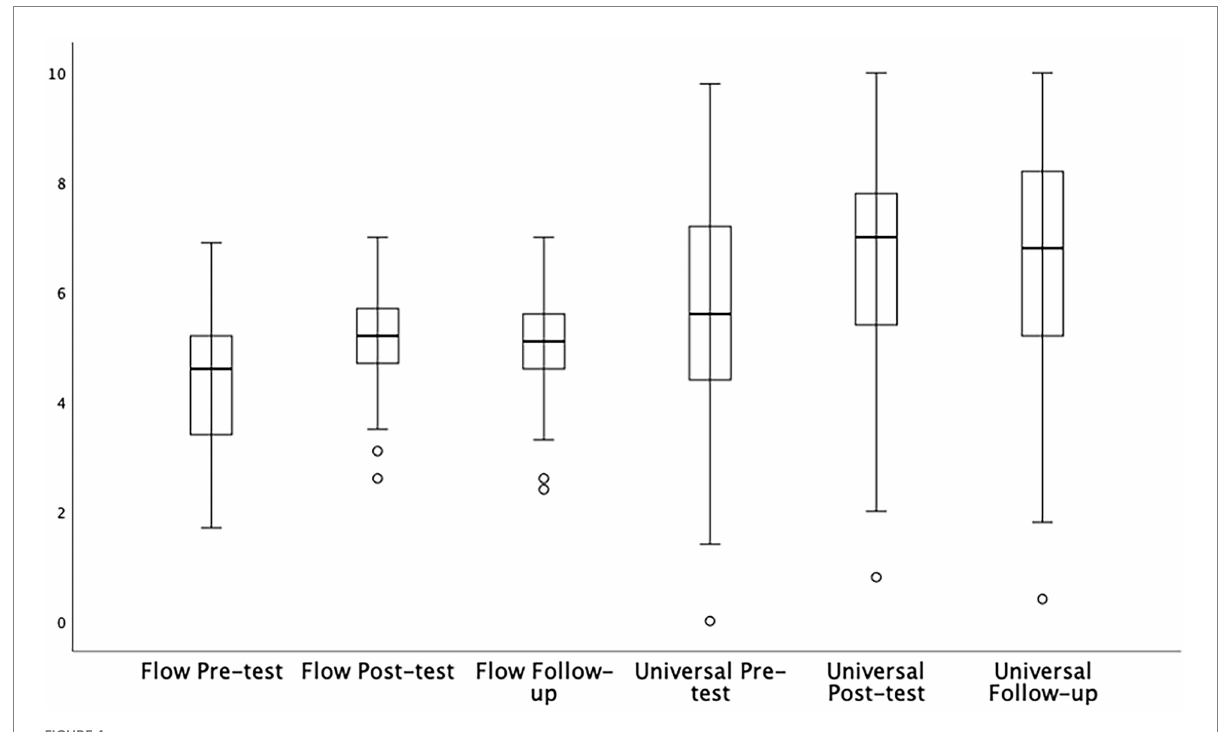
FIGURE 4 The distribution and outliers of flow states and transcendent experiences over time ( N =